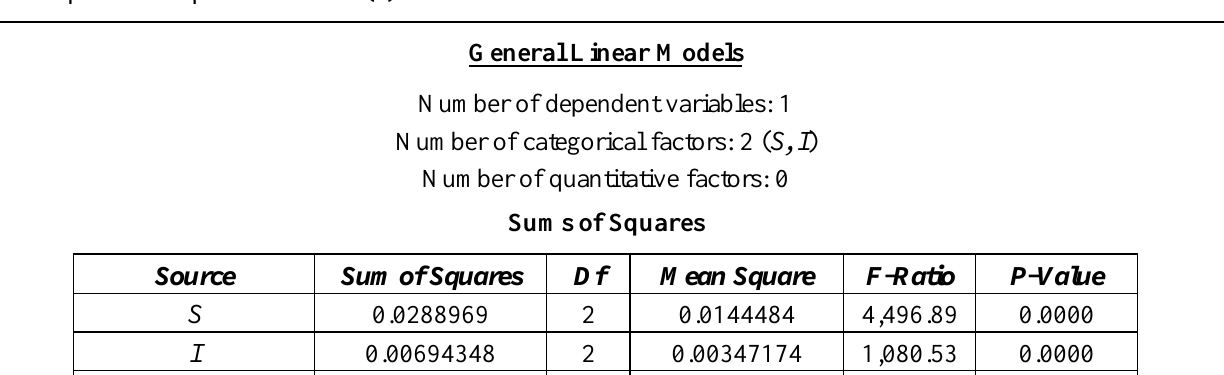
Table 9. Resulting ANOVA table of the temporal trend model, only with the effects of the spectral response factor S ( λ ) and the time interval factor I